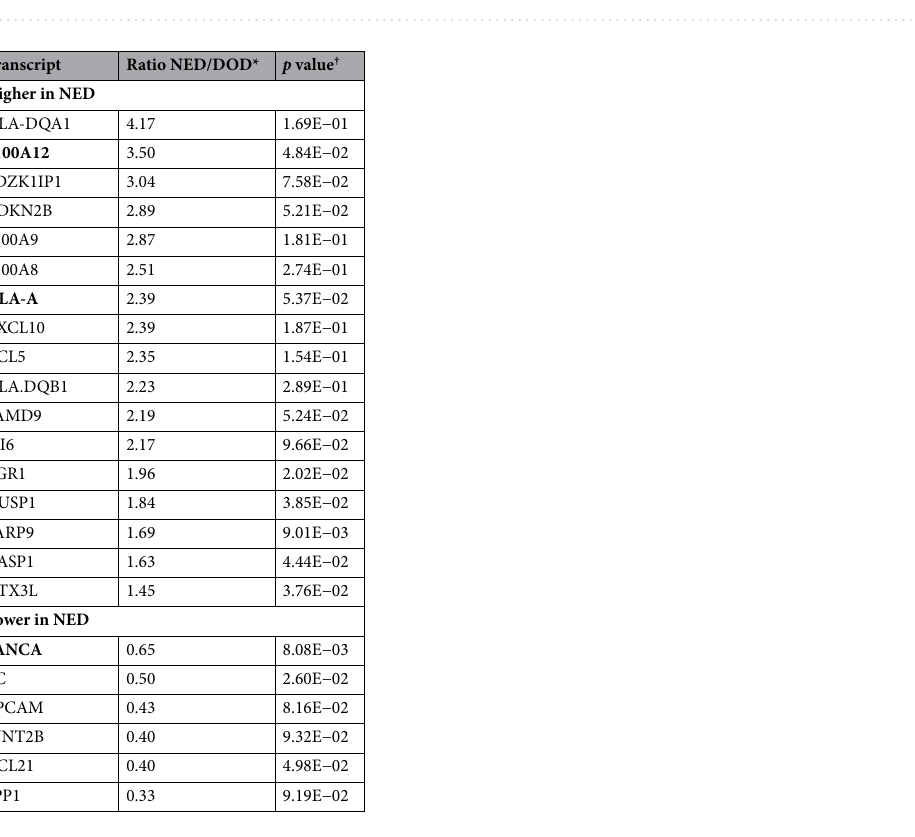
Table 3. Transcripts with > twofold and/or significant† differences in expression between the NED and DOD group in HPV negative HPSCC. *2-log ratios transformed into linear ratios. † Not adjusted for false discovery